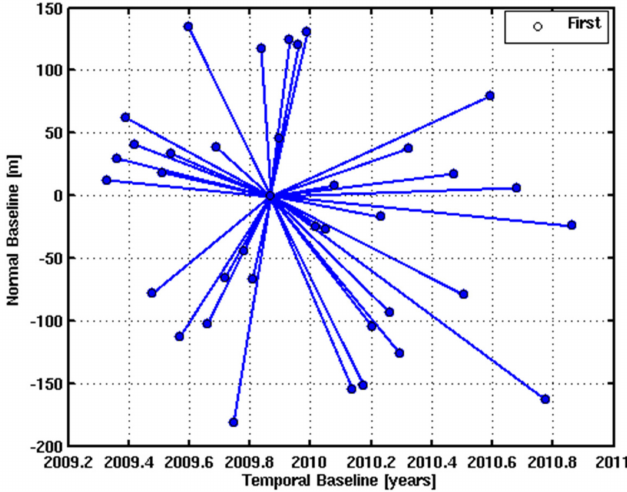
Figure 2. TSX images graph. x -axis: temporal baseline of the acquisitions. y -axis: normal baseline of the acquisitions (color scale: Average spatial coherence of the corresponding interferometric